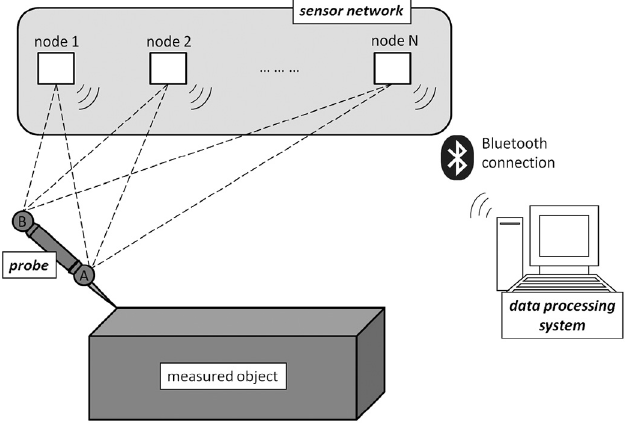
Fig. 1. MScMS-II architecture [8]. The dashed lines represent visual links between sensor nodes and retro-reflective spheres (indicated as A and B) equipping the hand-held probe. The Bluetooth connection is established between each node and the processing system.